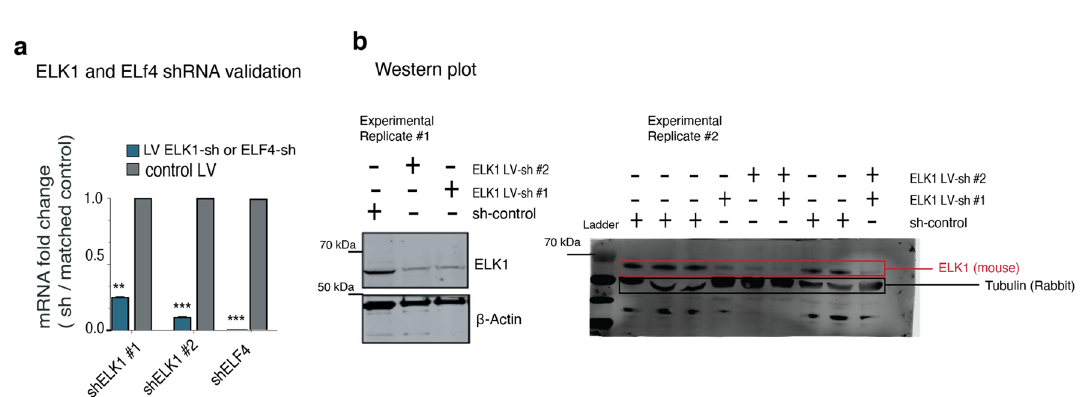
Figure 23. Pull down (IP) assay and detection of direct interaction between CHD8 and ELK1. ( a ) Two independent experimental replicates for IP of CHD8 and detection of ELK1 with western blot. Experimental replicate #1 shown in Fig. 24a.